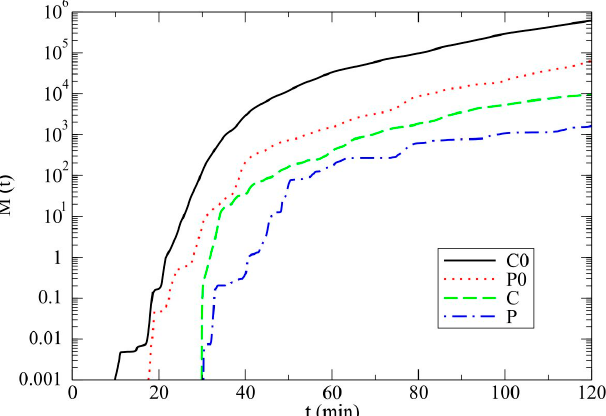
Figure 6. As in Figure 5, but for the cumulative sum of the mass contribution, M (tonnes) to rain obtained by autoconversions of cloud droplets and of drizzle. Atmosphere 2018 , 9 , 13